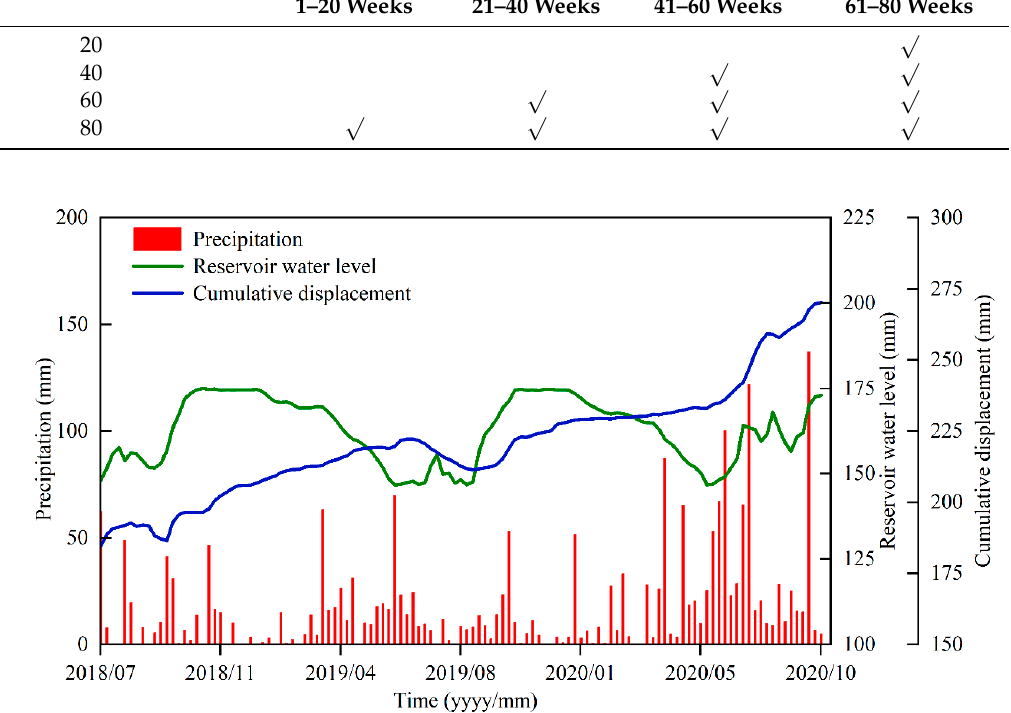
Figure 5. Precipitation, reservoir water level, and cumulative displacement at the SZY-03 monitoring point of the Shuizhuyuan landslide.